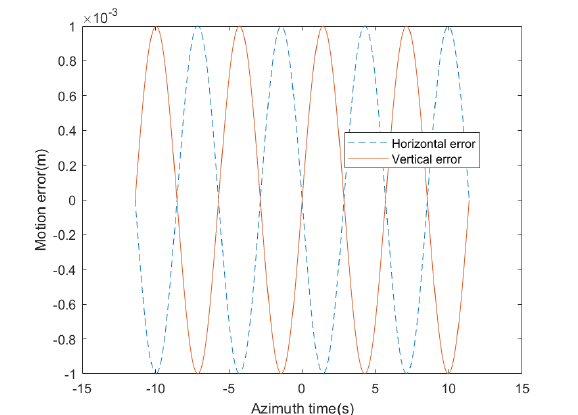
Figure 7. Verticaland horizontal errors.